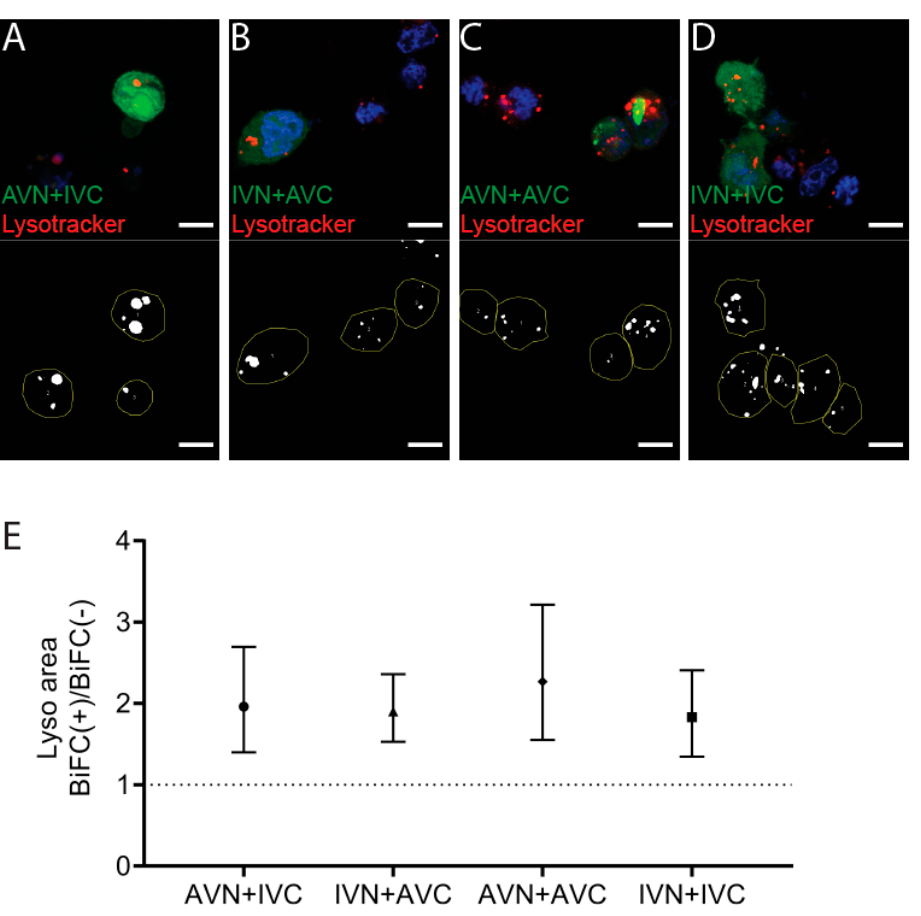
Figure 3. Expression of A β , IAPP, and A β + IAPP increase the lysosomal area. Confocal images of HEK293 cells transfected with ( A ) AVN + IVC, ( B ) IVN + AVC, ( C ) AVN + AVC, and ( D ) IVN + IVC stained with Lysotracker (red) and DAPI (blue). Below are the corresponding binary images displaying the cell area (yellow circle) and lysosomal area (white). ( E ) The ratio of the lysosomal area in BiFC(+)/BiFC( − ) cells of AVN + IVC, IVN + AVC, AVN + AVC, and IVN + IVC-transfected cells. Scale bar: 10 µ m. The results were analyzed by the method of EC Fieller and presented as the mean with a 95% confidence interval.